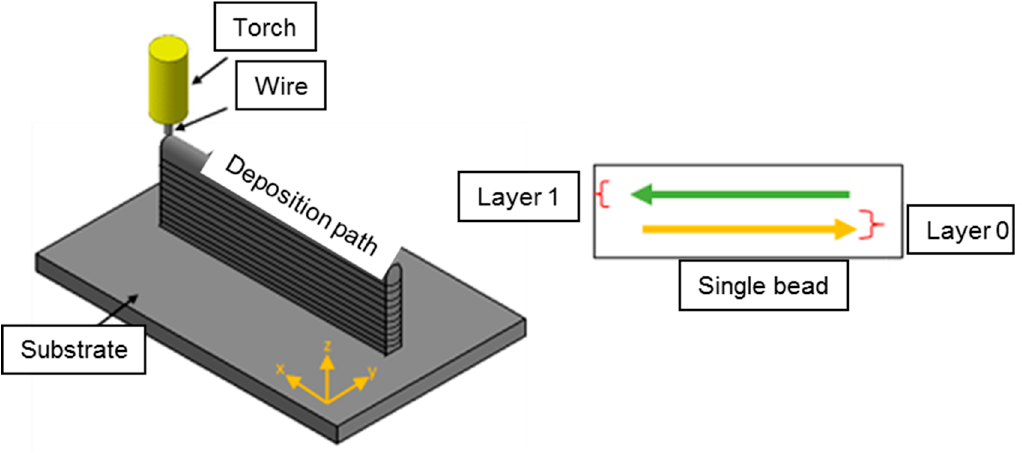
Figure 3. Graphical representation of the layer sequence.